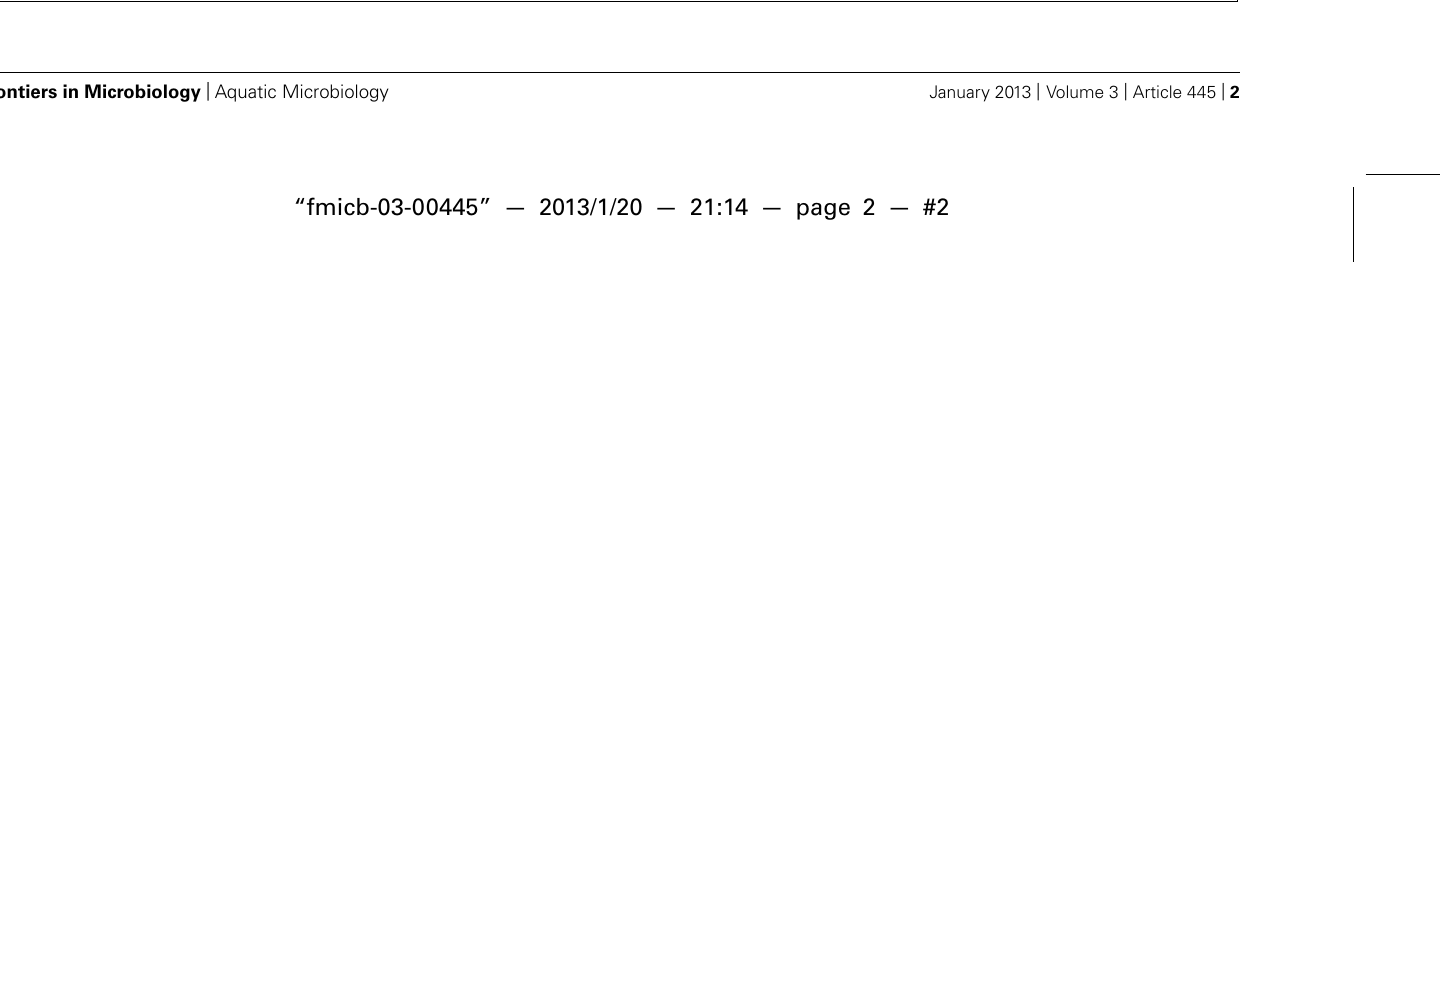
FIGURE 1 | Map of study plots in the Great Sippewissett Marsh, Falmouth, MA, USA. C, control plots with no fertilizer added; LF, low fertilization; HF, high fertilization; XF, extra high fertilization (levels of fertilization can be found in Section “Materials and